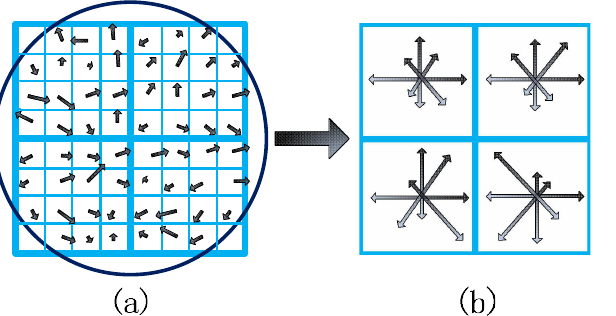
Figure 3. Description of key points: ( a ) image gradients around key points; ( b ) keypoint descriptors.